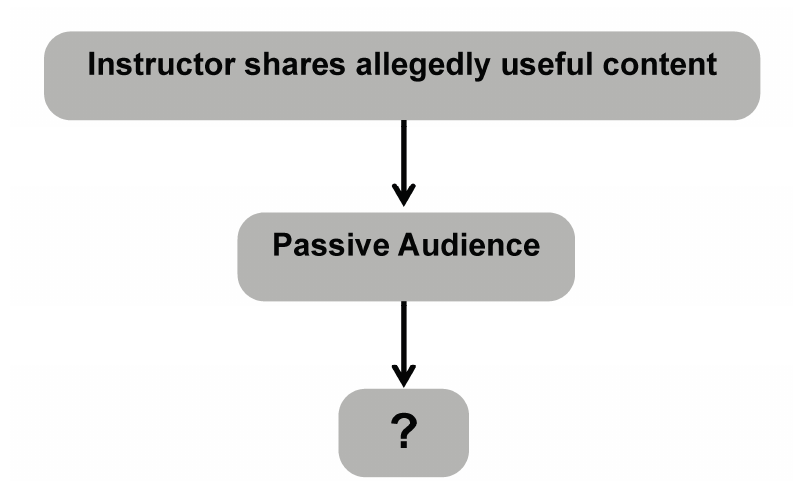
Figure 1. A simplified representation of the conventional learning